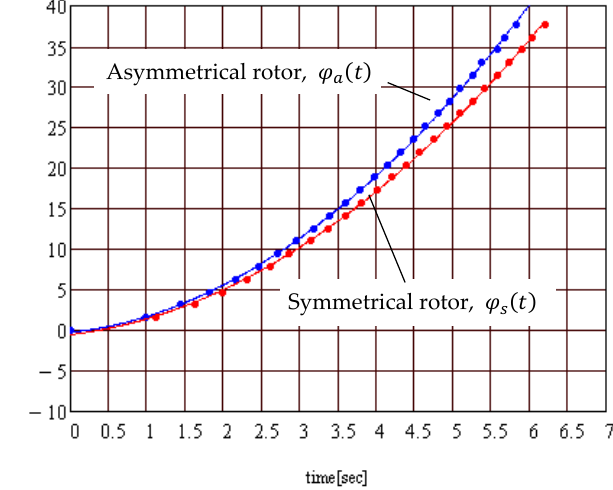
Figure 21. Time dependency of the rolling angle for the symmetrical and asymmetrical rotor.